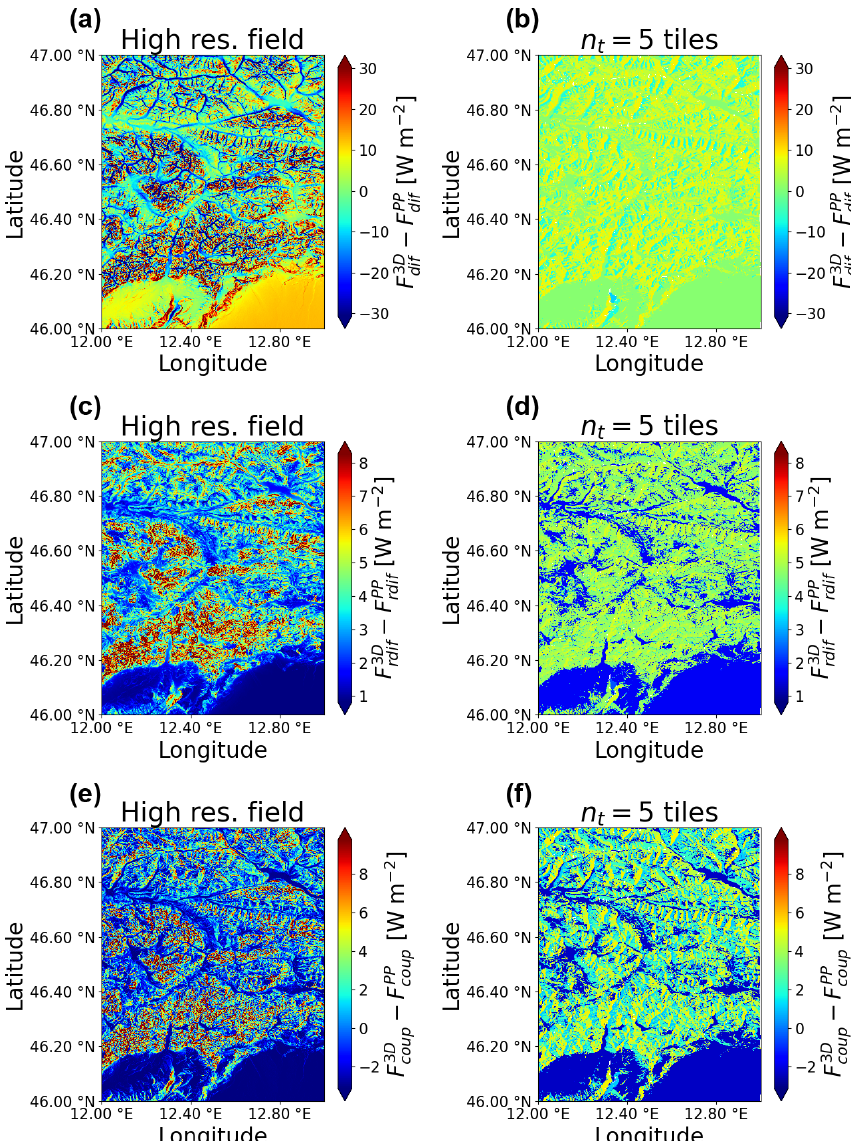
Figure 16. Downward radiation differences between 3D and PP fluxes for high-resolution predictions (a, c, e) and predictions using five tiles (b, d, f) for each flux component. Results are shown for a representative case of cloudy-sky conditions and cos θ 0 = 0 . 4. Direct and reflected direct fluxes are zero in this